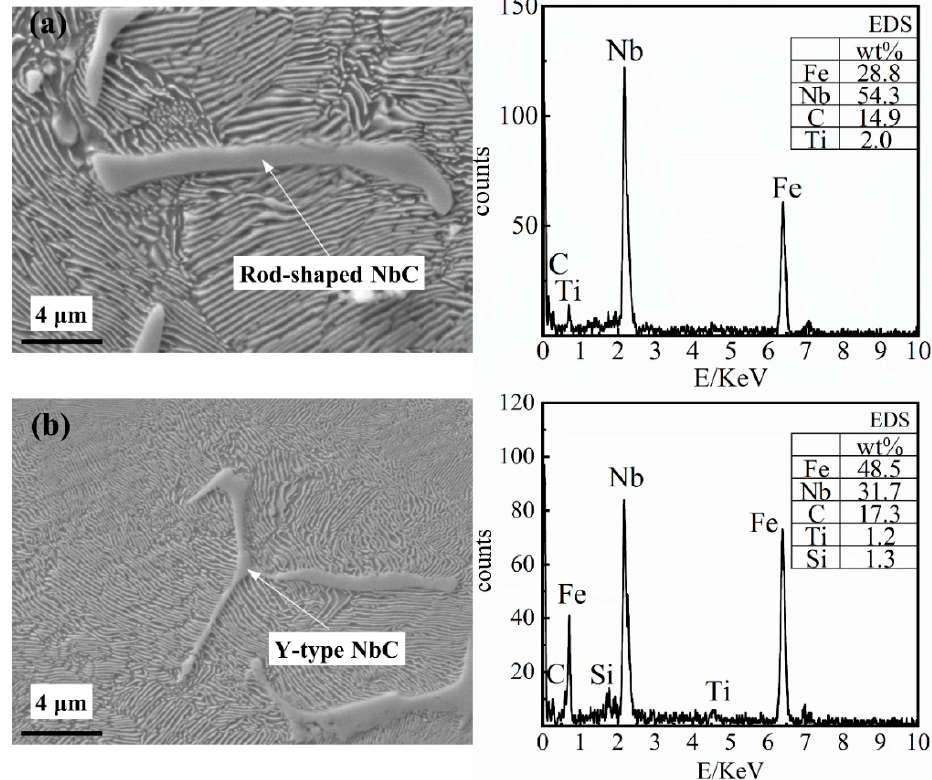
Figure 6. The energy-dispersive X-ray spectroscope (EDS) results of the elongated NbC niobium-rich phase, ( a ) Rod-shaped NbC; ( b ) Y-type NbC.